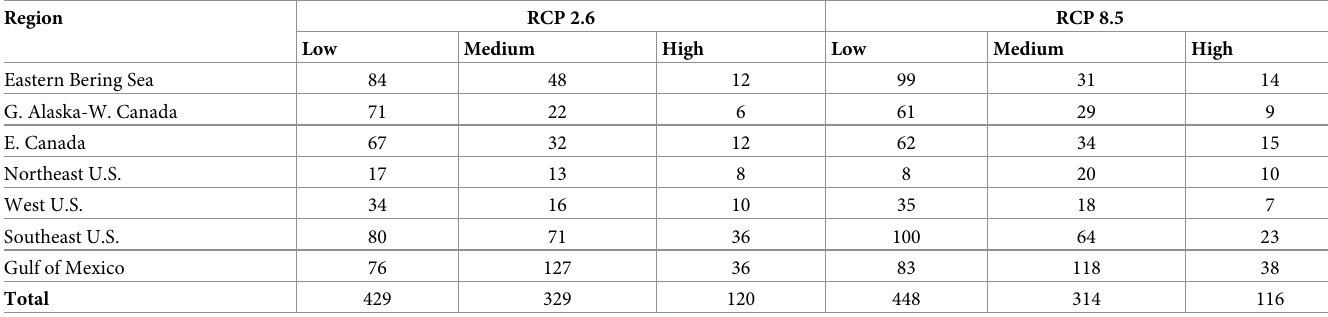
Table 4. Projection uncertainty of species by region. Region